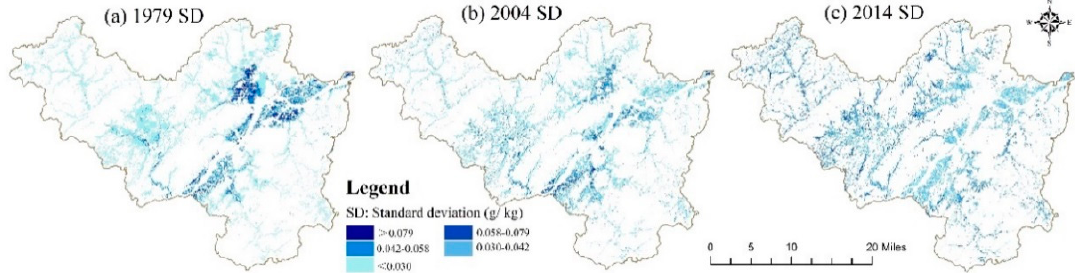
Figure 3. Maps of the standard deviation (SD) created using the RF model with 100 runs in ( a ) 1979, ( b ) 2004 and ( c ) 2014.